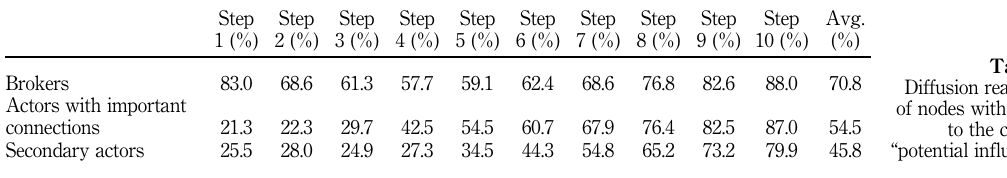
Figure 10. Penetration profile in each category according to the proposed model